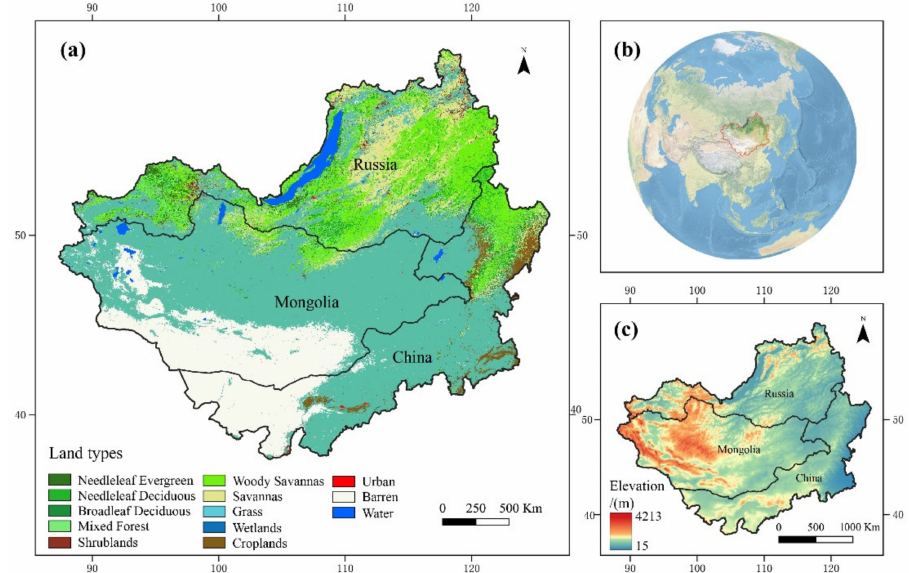
Figure 1. Geographical location and land cover types of the Mongolian Plateau. ( a ) The land cover for the Mongolian Plateau; data were sourced from https://ladsweb.modaps.eosdis.nasa.gov/search/ order/1/MCD12Q1--6 (accessed on 1 August 2022). ( b ) Location of the Mongolian Plateau in the world, ( c ) Mongolian Plateau elevation range; data were sourced from https://worldclim.org/data/ worldclim21.html (accessed on 1 August